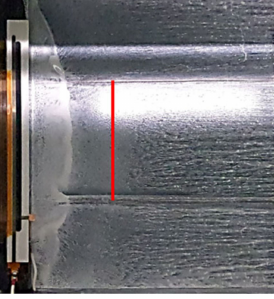
Figure 11. Oil flow